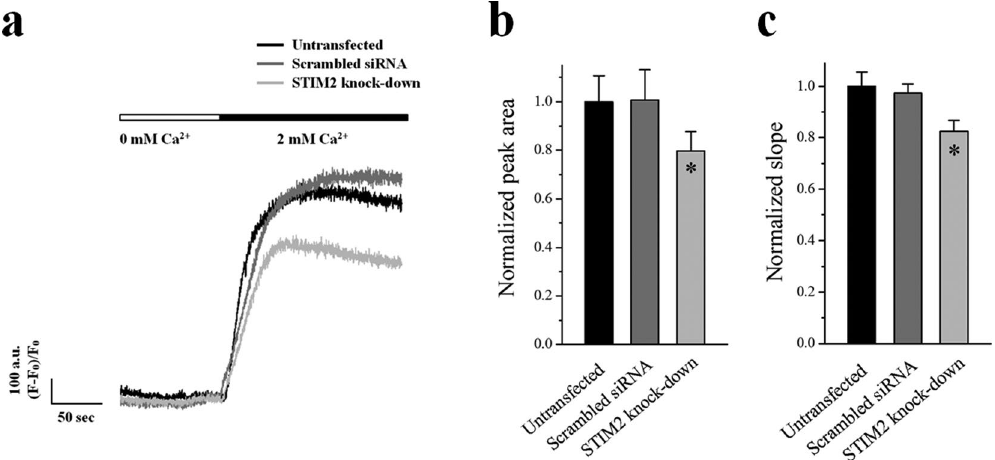
Figure 4. Decreased SOCE by STIM2-knockdown. The Ca 2 + in the SR of the STIM2-knockdown myotubes was depleted by the treatment of TG (2.5 μ M) in the absence of extracellular Ca 2 + . Extracellular Ca 2 + (2 mM) was applied to the myotubes to induce SOCE. ( a ) A representative trace for each group is shown. The results are summarized as bar graphs for the area under the peaks ( b ) or the slope at the rising phase of the peaks ( c ). * Significant difference compared with the untransfected control ( P < 0.05). The values are presented as the mean ± S.E. for the number of myotubes shown in the parentheses of Table 4. SOCE was significantly decreased by